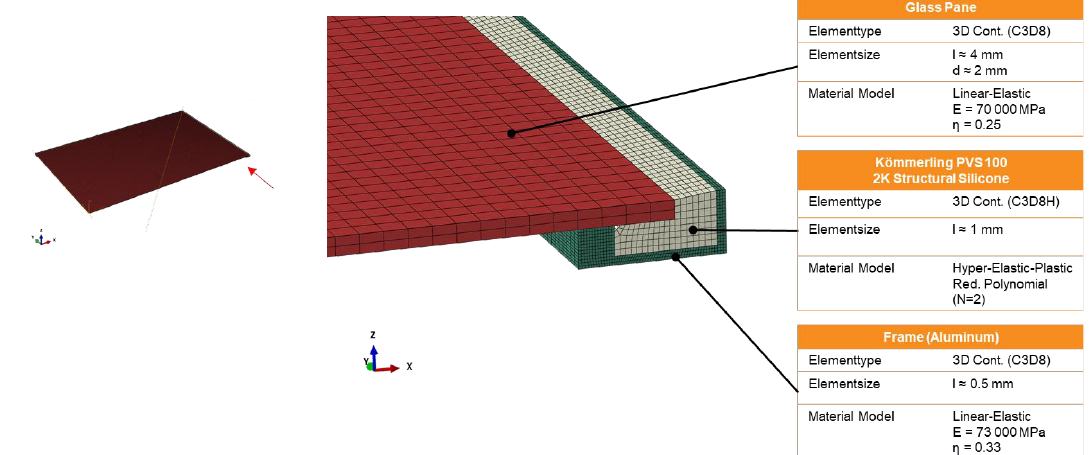
Fig. 4 FE model of the solar thermal module with L-shaped adhesive joint with used material models and